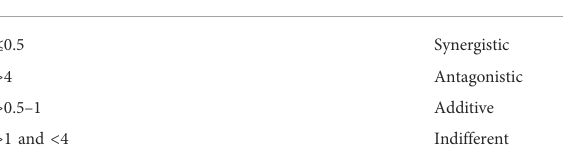
TABLE 1 Interpretation of FICI